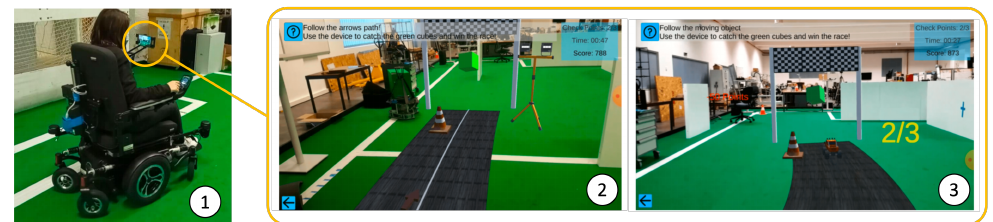
Figure 1. User experiencingthe augmented reality serious game (ARSG): 1—set up used for control- ling the robotic wheelchair; 2—following the white line in the middle of the road; 3—following the path of the moving object (car) until it